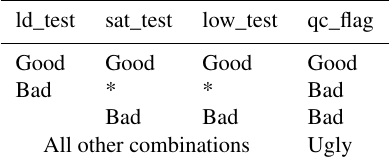
Table 5. Determination of qc_flag value based on success of sound- ing in the three QC tests – ld_test, sat_test and low_test. The asterisk indicates that any value for the test satisfies the condition.